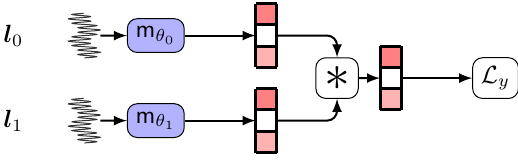
Figure 1: Scheme-aware model, with known P.o.Is for each share and a known masking scheme, but unknown random